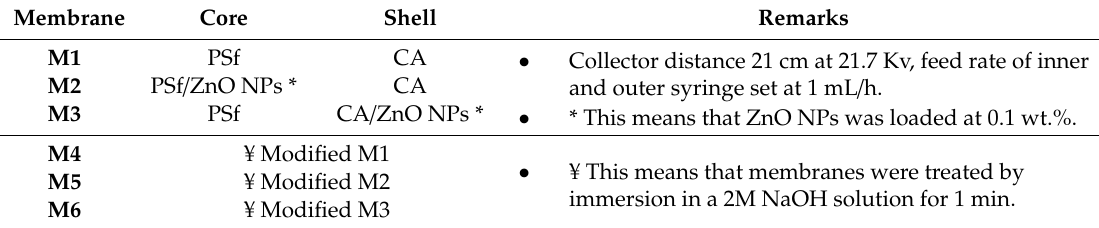
Table 1. Fabrication parameters of the developed nanofibrous membranes at room temperature; the table shows the core and shell materials and electrospinning setup